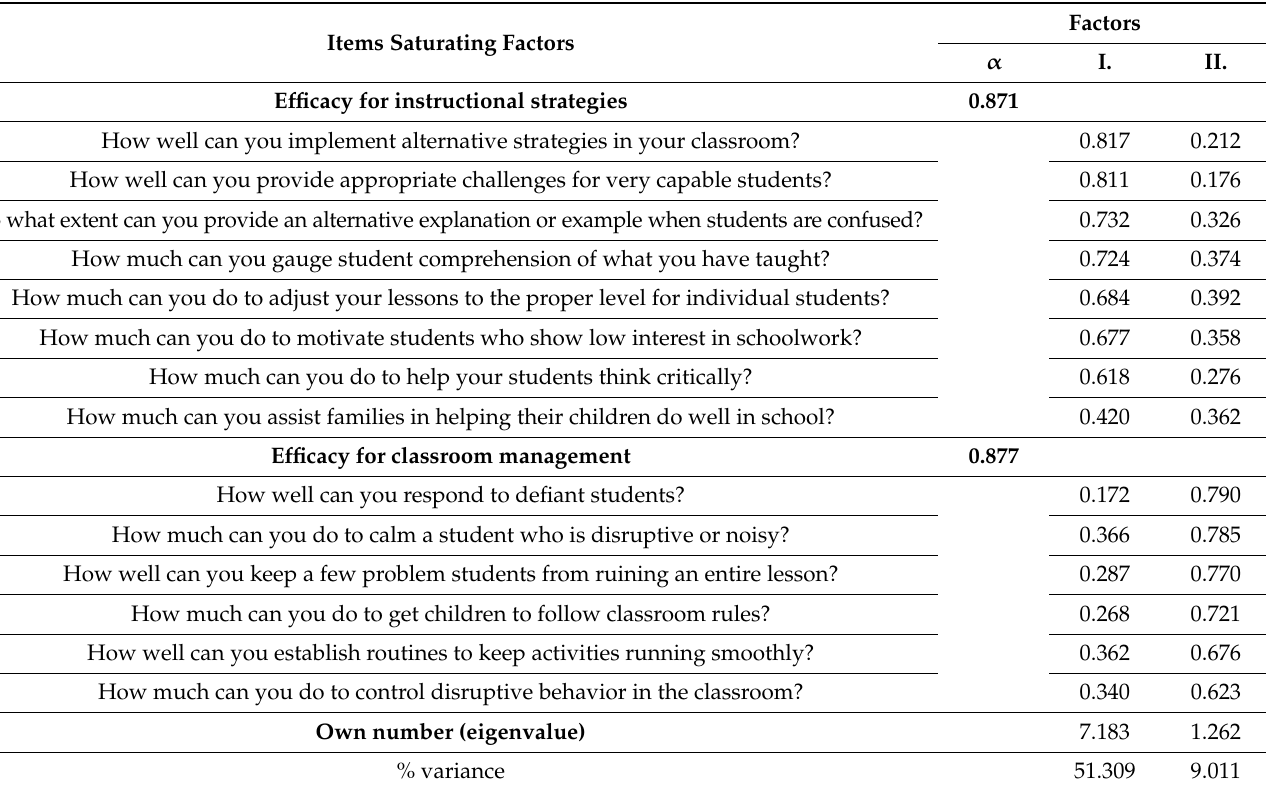
Table 2. T Items saturating individual factors after factor